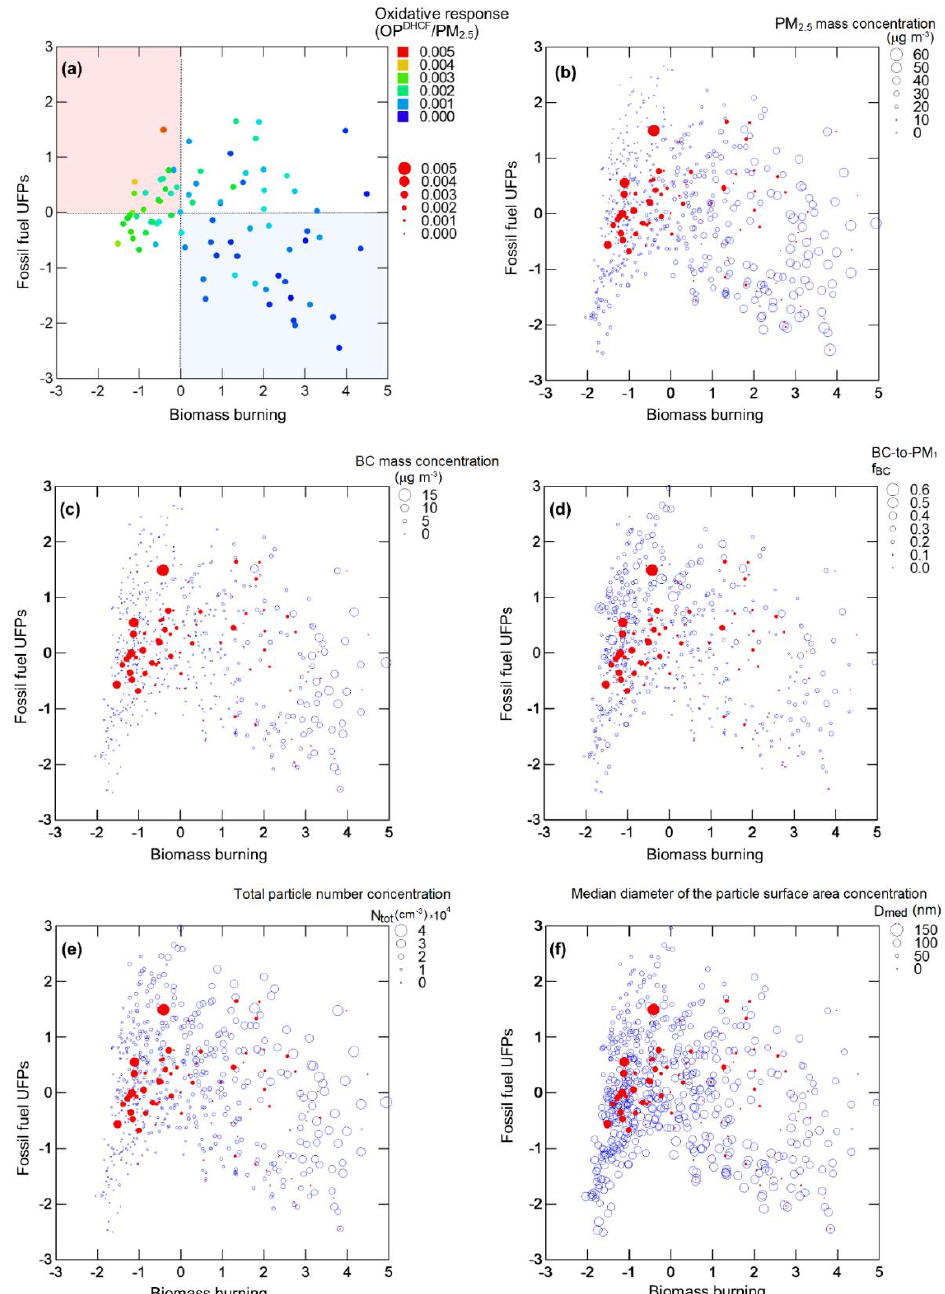
Figure 3. Relation between the two combustion derived aerosol types apportioned (fossil fuel UFPs and biomass burning), the oxidative responses (OP DHCF / PM 2.5 , panel ( a )), and the aerosol metrics (PM 2.5 mass concentration, panel ( b ); BC mass concentration, panel ( c ); BC-to-PM 1 mass fraction, panel ( d ); particle number concentration, panel ( e ); median particle diameter of the surface area size distribution, panel ( f )). The oxidative responses in panels b-f are indicated by red dots. Data time resolution is 2 h in panel ( a ), and 1 h in panels ( b )–( f ).